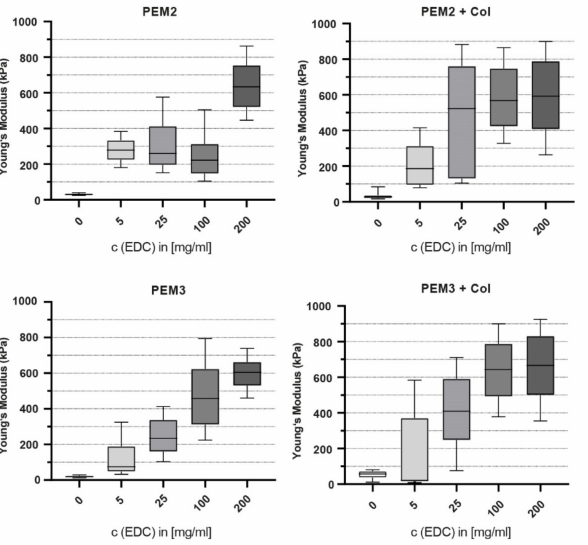
Figure 4. Atomic force microscopy (AFM) of cross-linked PEM films. Measurements were performed in aqueous solution taking the swollen state of the PEM films into consideration. From each sample three different areas with a dimension of (25 × 25) µ m 2 with a grid of 12 × 12 single measurements were measured. For the statistical analysis the measurements were conducted with three independent